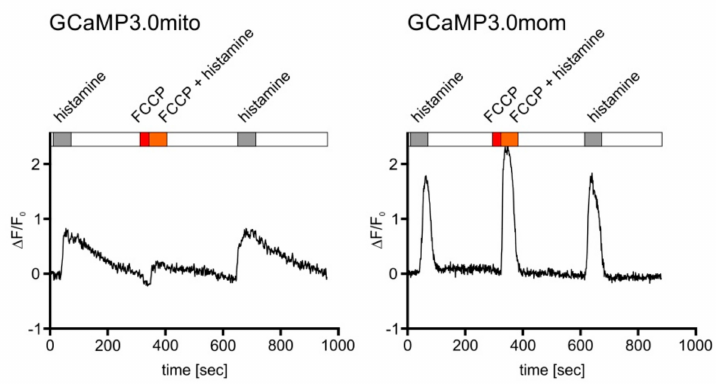
Figure 6. Mitochondrial targeted GCaMP3.0 versions respond differently, yet specifically, to Ca 2+ signals. Cells constitutively expressing either the GCaMP3.0mito or GCaMP3.0mom version of the sensor were superfused with extracellular solution (ES: 120 mM NaCl, 5 mM KCl, 2 mM MgCl 2 , 2 mM CaCl 2 , 10 mM HEPES, 10 mM glucose, pH 7.4; white bar), with ES containing 10 µ M histamine (gray bar), ES containing 10 µ M FCCP (red bar), or ES containing 10 µ M histamine and 10 µ M FCCP (orange bar). Ca 2+ -dependent fluorescence signals in individual cells were registered. Application of FCCP and FCCP/histamine (red and orange bar) resulted in a strong reduction of the fluorescence signals. After wash-out of FCCP and subsequent stimulation with histamine, the fluorescence signal recovered and reached the initial value and shape. In cells constitutively expressing the GCaMP3.0mom variant, targeted to the mitochondrial outer membrane, application of FCCP did not result in a reduction of the Ca 2+ -dependent fluorescence compared to stimulation with histamine alone. For comparison, the change in fluorescence intensity normalized to basal fluorescence intensity ( ∆ F/F 0 ) is plotted against time